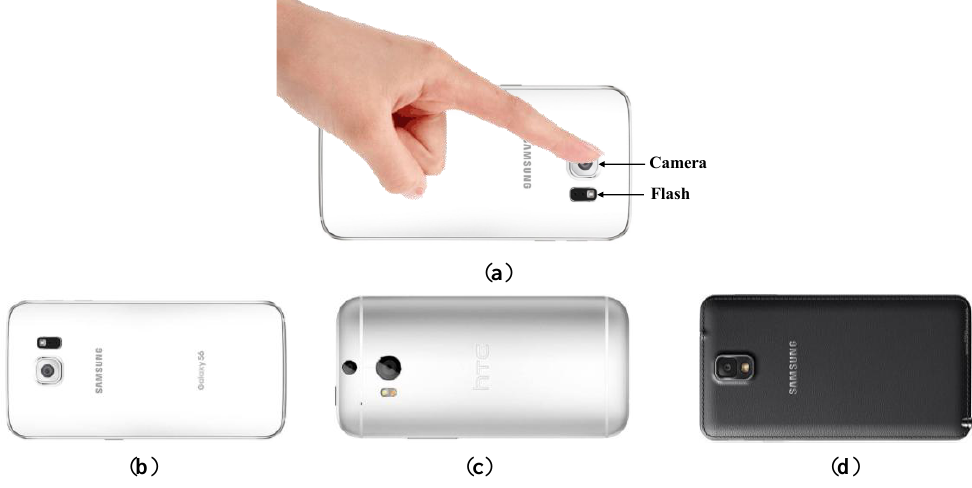
Figure 1. Smartphones used for evaluating performance: ( a ) General scheme to acquire videos from three devices; ( b ) Samsung Galaxy S6; ( c ) HTC One M8; ( d ) Samsung Galaxy Note 3.